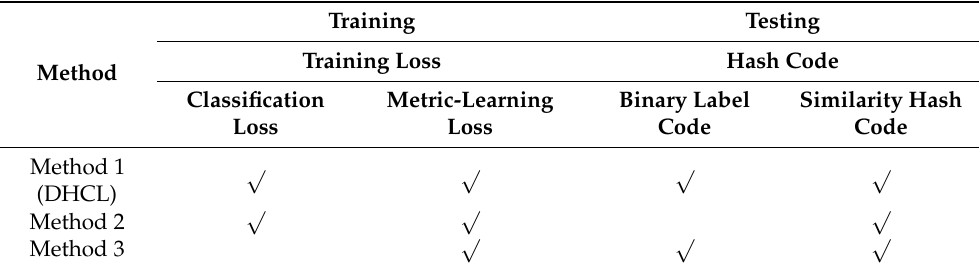
Table 4. Settings of evaluation experiment. Method 1 is DHCL. Method 2 uses classification loss and metric-learning loss, but only similarity hash codes are used in the retrieval process. Method 3 uses only metric-learning loss and uses labeled binary codes and similarity hash codes in the retrieval